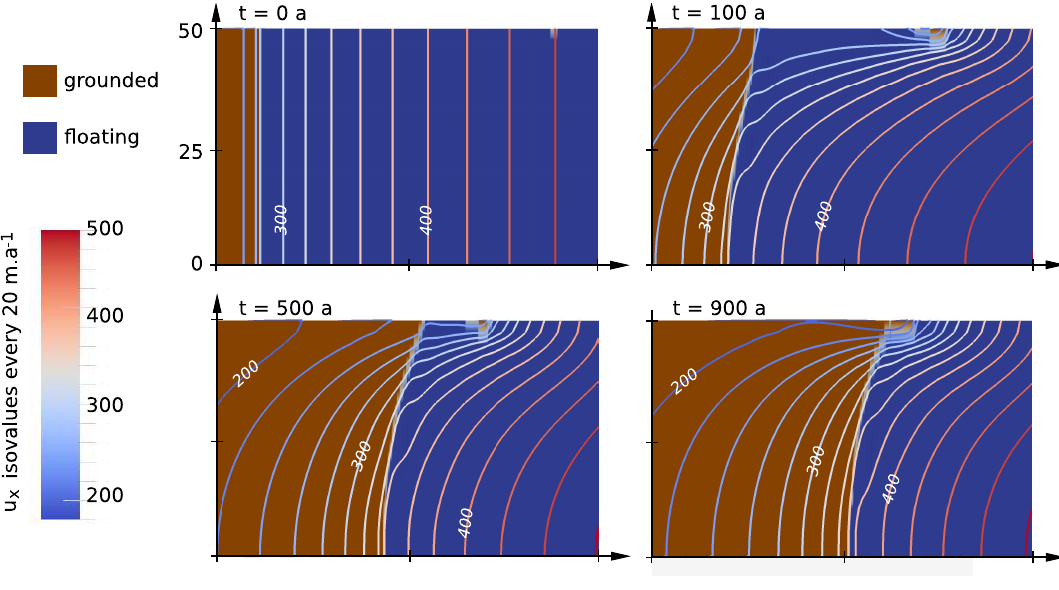
Fig. 8. Effect of the pinning point on the grounding line migration, for selected time-levels between 0 and 900 a. Isovalues of the basal velocity norm are also represented every 20 m a − 1 .